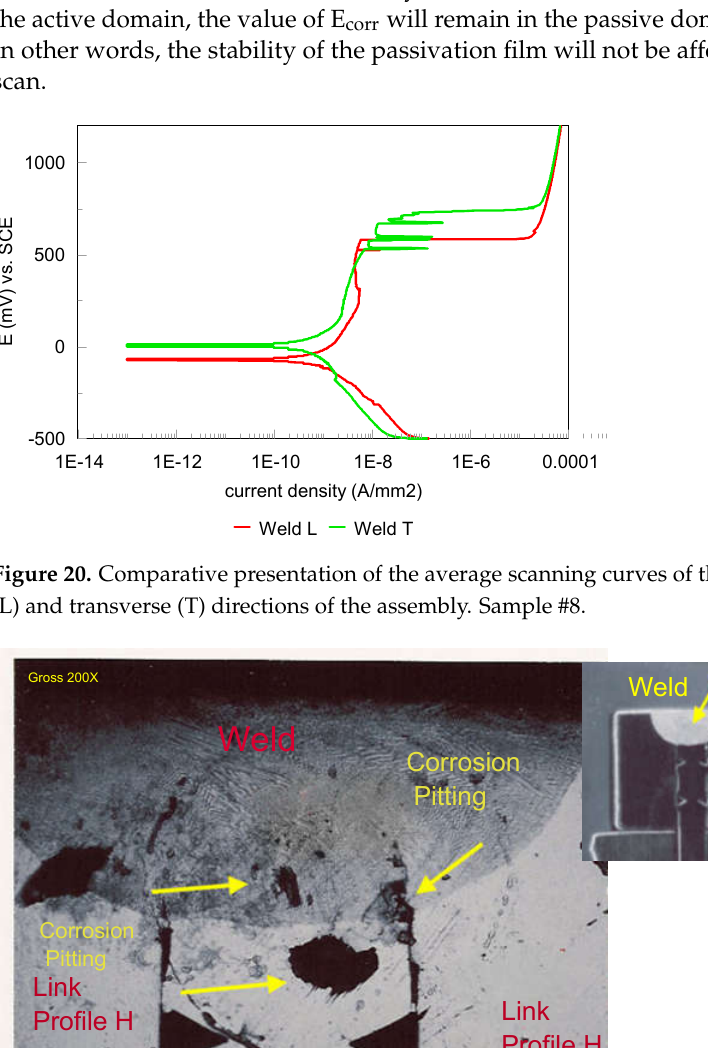
Figure 19. Microelectrode positioned at the link/pin interface. Optical examination, magnification